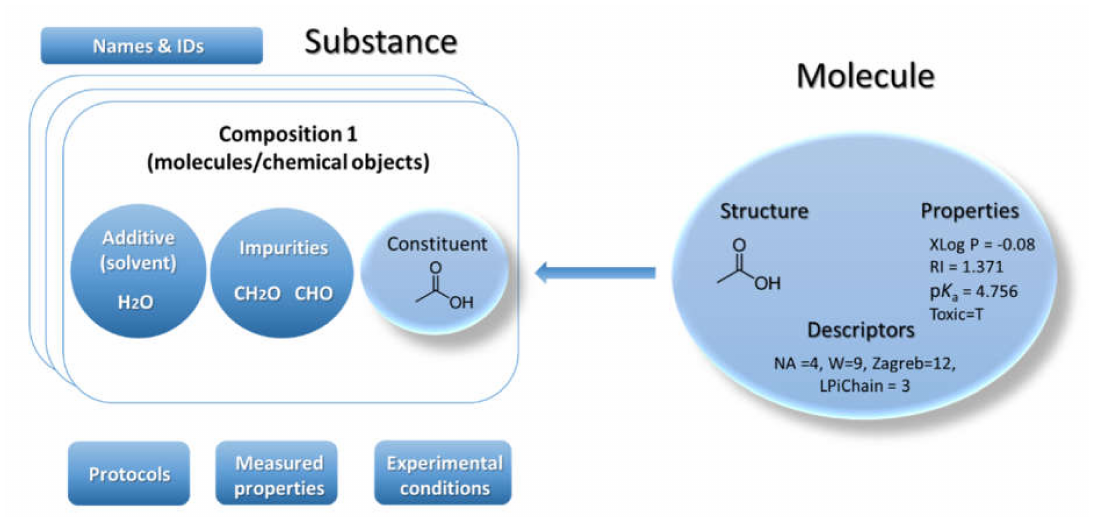
Figure 1. Substance data model / IUCLID inspired / ( left ) vs. Classical structure model ( right